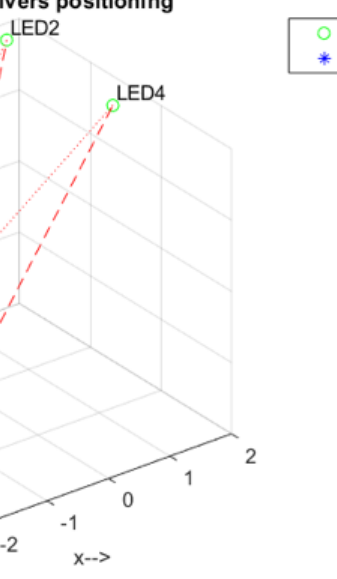
Figure 6. Spatial distribution of LEDs and